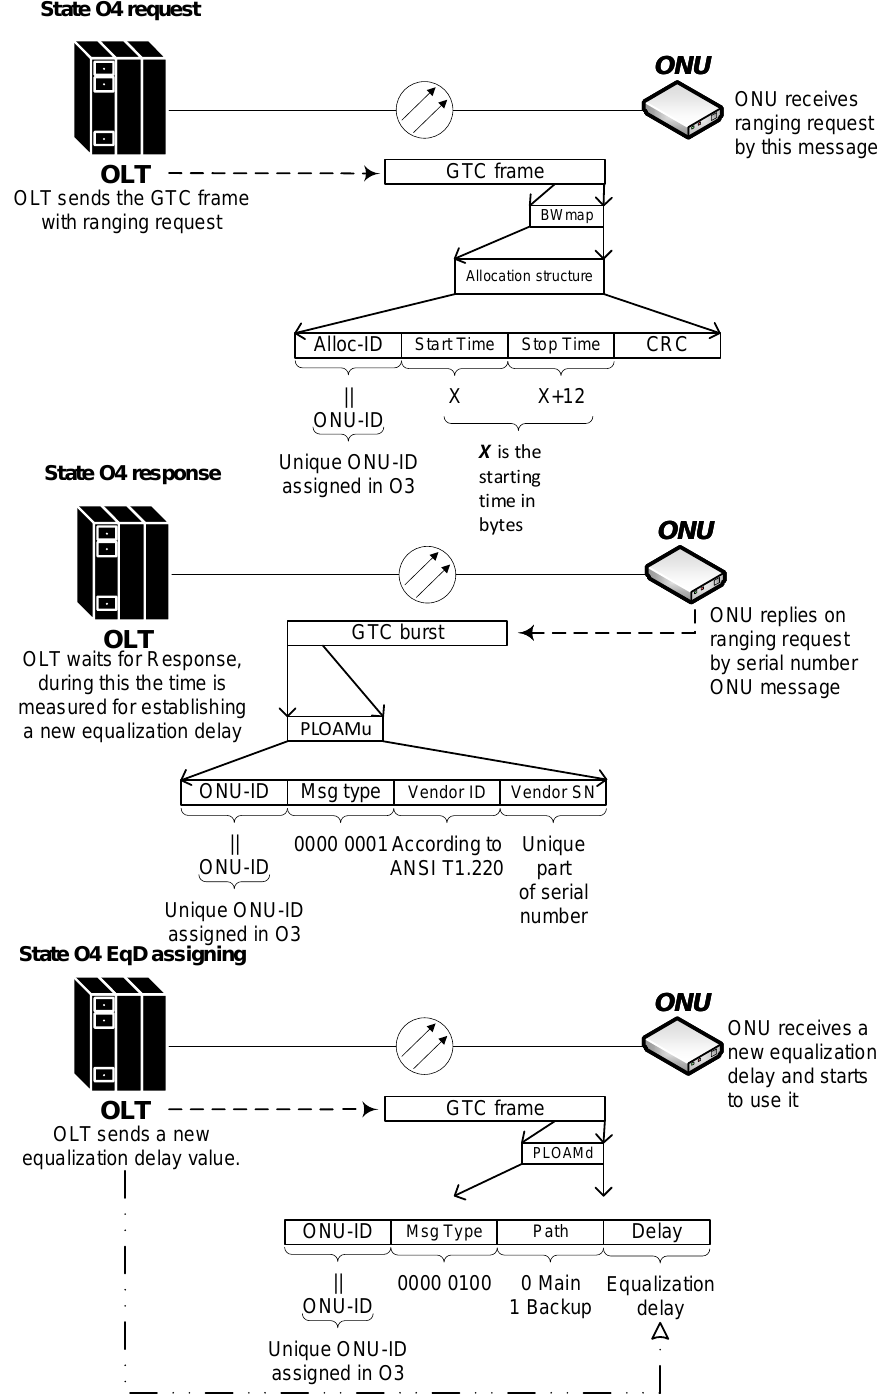
Figure 10. Activation process of ONU in a GPON network with PLOAM message details for state